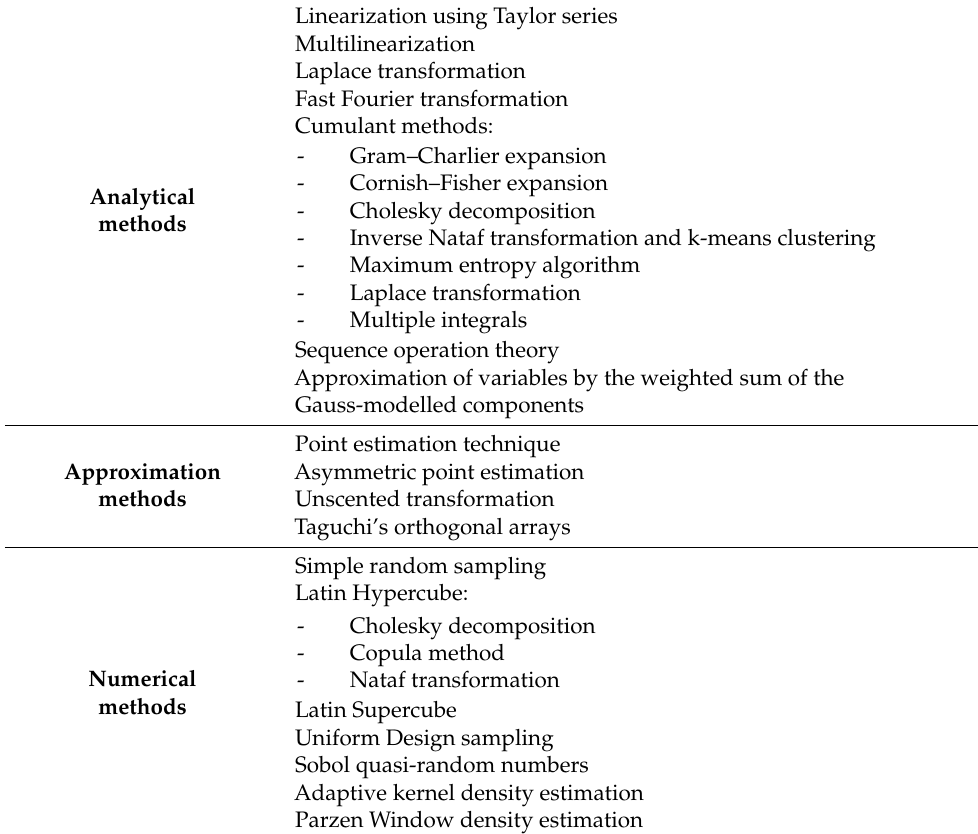
Table 1. Overview of developed PLF